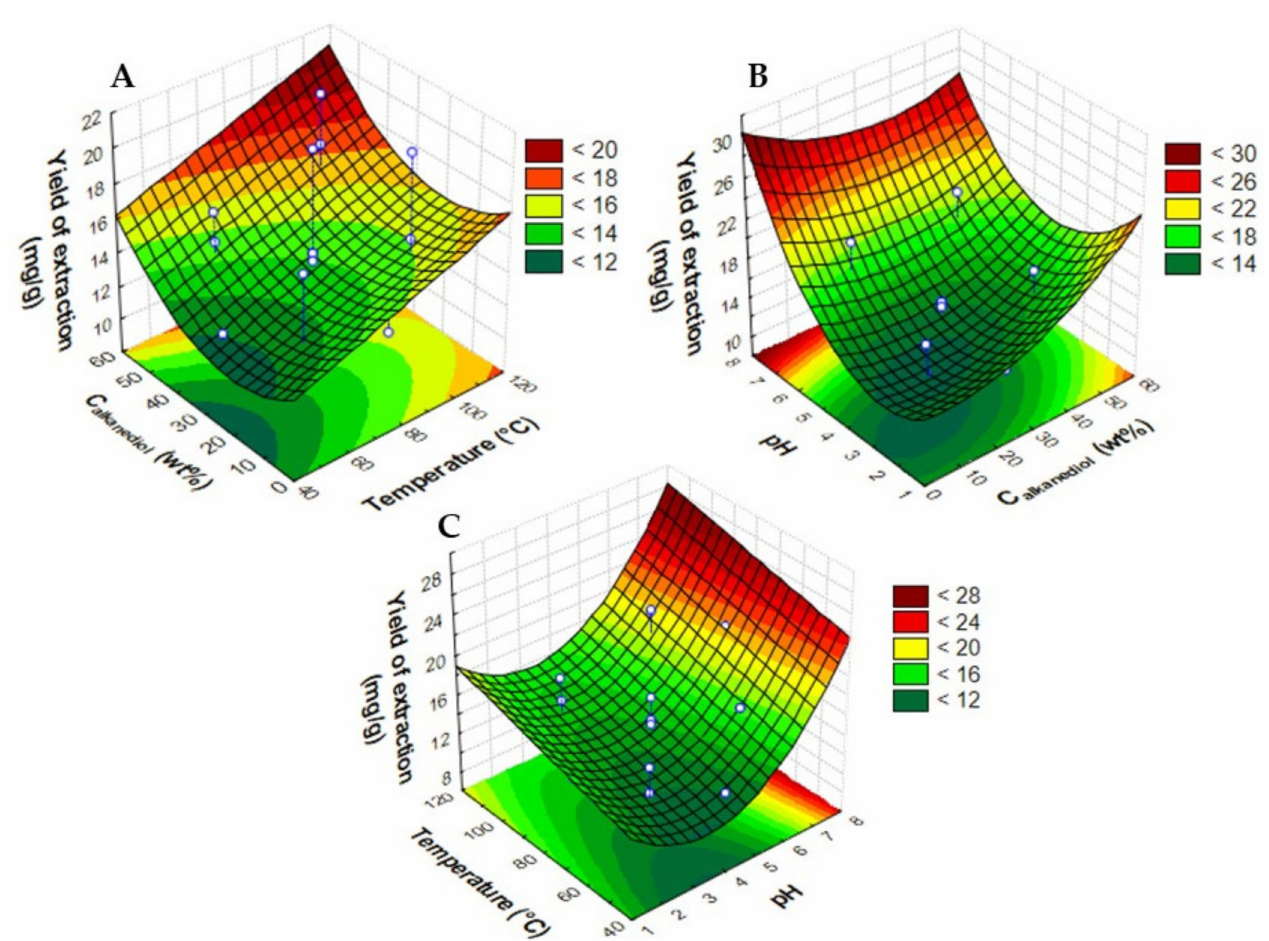
Figure 1. Response surface plots obtained for the CCRD (2 3 ) applying PLE regarding the alkanediol concentration (Calkanediol in wt%), temperature ( ◦ C), and pH in terms of yield of extraction of anthocyanins (mg anthocyanins · g dry biomass − 1 ). ( A ) C alkanediol and Temperature, ( B ) pH and C alkanediol , and ( C ) Temperature and